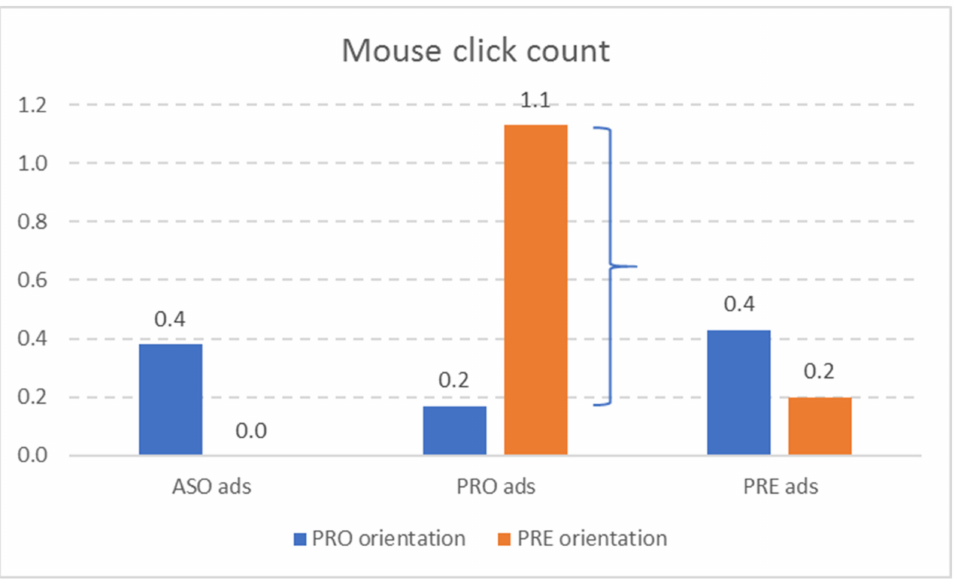
Figure 12. Mean graph for mcc and ad type vs. regulatory